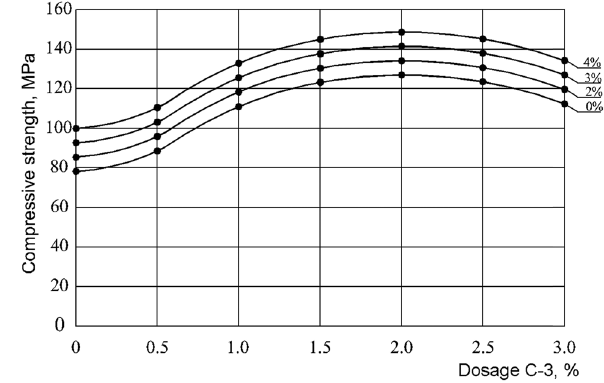
Figure 10: Compressive strength of a 28 days old plasticized, dis - persed fi ber - reinforced